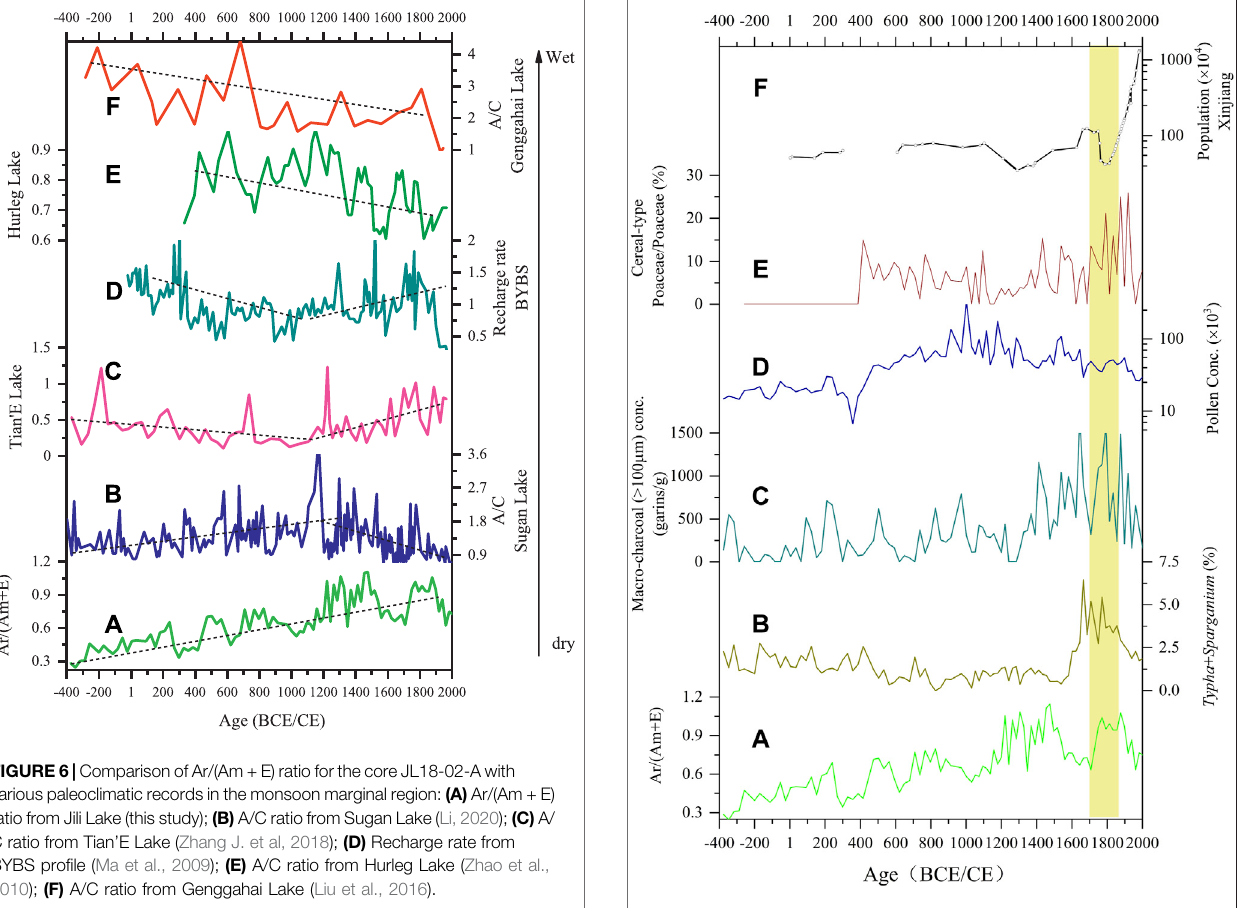
FIGURE7| Comparison ofAr/(Am+E)ratioforthecoreJL18-02-Awith population in Xinjiang: (A) Ar/(Am + E) ratio from Jili Lake (this study); (B) The percentage of Typha and Sparganium from Jili Lake (this study); (C) Macro- charcoal ( > 100 μ m) concentration from Jili Lake (this study); (D) Pollen concentration form Jili Lake (this study, Y-axis is a log scale); (E) Cereal-type Poaceae/Poaceae(Ce/Po)fromJiliLake(thisstudy); (F) PopulationinXinjiang, Y-axis is a log scale (Zhao and Xie, 1988). The orange area indicates a population growth period.